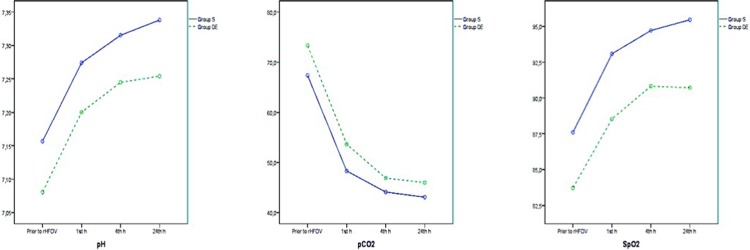
2A, 2B and 2C. Changes in pH, pCO2 and SpO2.